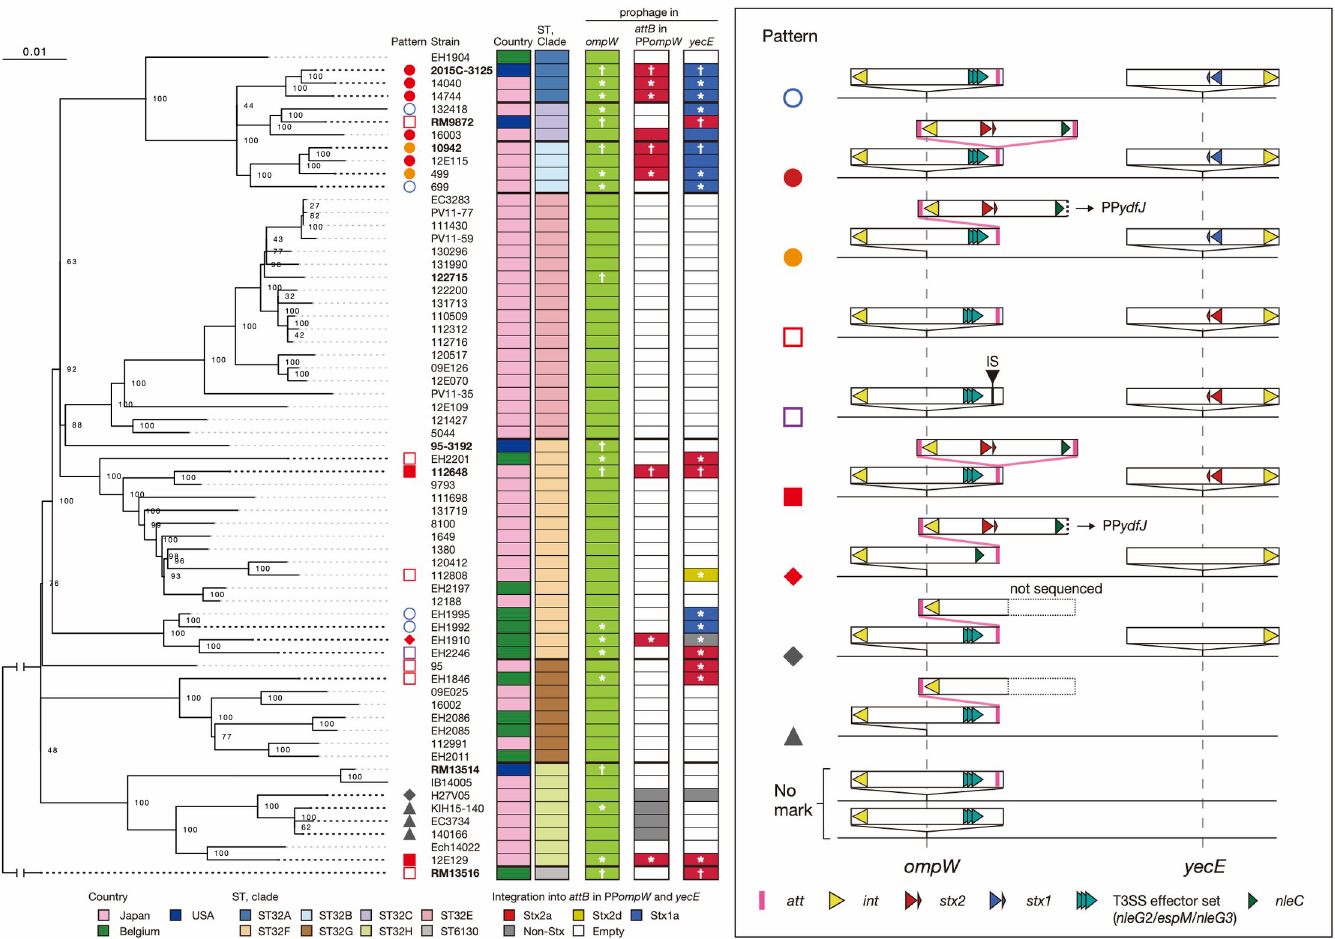
Fig 2. Variation in the prophage content at the ompW , attB in PP ompW , and yecE loci in STEC O145:H28. In the left panel, an ML tree of 64 O145:H28 strains is shown. Completely sequenced strains are indicated in bold (plasmids were not finished for strain 2015C-3125). The tree was constructed based on the recombination- free SNPs (3,277 sites) identified on the conserved chromosome backbone (3,961,936 bp in total length) by RAxML using the GTR gamma substitution model [43]. The reliabilities of the tree’ s internal branches were assessed using bootstrapping with 1,000 pseudoreplicates. Along with the tree, the geographic and ST/clade information of strains, the presence or absence of prophages at three loci ( ompW , attB in PP ompW , and yecE ) and the types of prophages at the attB in PP ompW and yecE loci are shown. Prophages sequenced in this study and those in the finished genomes are indicated by asterisks and daggers, respectively. Note that the attB in PP ompW sequence is missing from the PP ompW s of strains EH2246 and 12E109; a deletion in the latter stain was detected in its draft genome assembly. The bar indicates the mean number of nucleotide substitutions per site. In the right panel, the patterns of the prophage content at the three loci are schematically presented. Strains showing each pattern are also indicated in the left panel by diagrams. For more details about the T3SS effector set, see Fig 3 and main text. Note that we detected recombination between the Stx2a phage at attB in PP ompW and a prophage present at the ydfJ locus that induced a large chromosome inversion in strains 10942 and 499. In strain EH1910, an inversion appeared to have occurred by the recombination between PP ompW and a prophage at ydfJ .